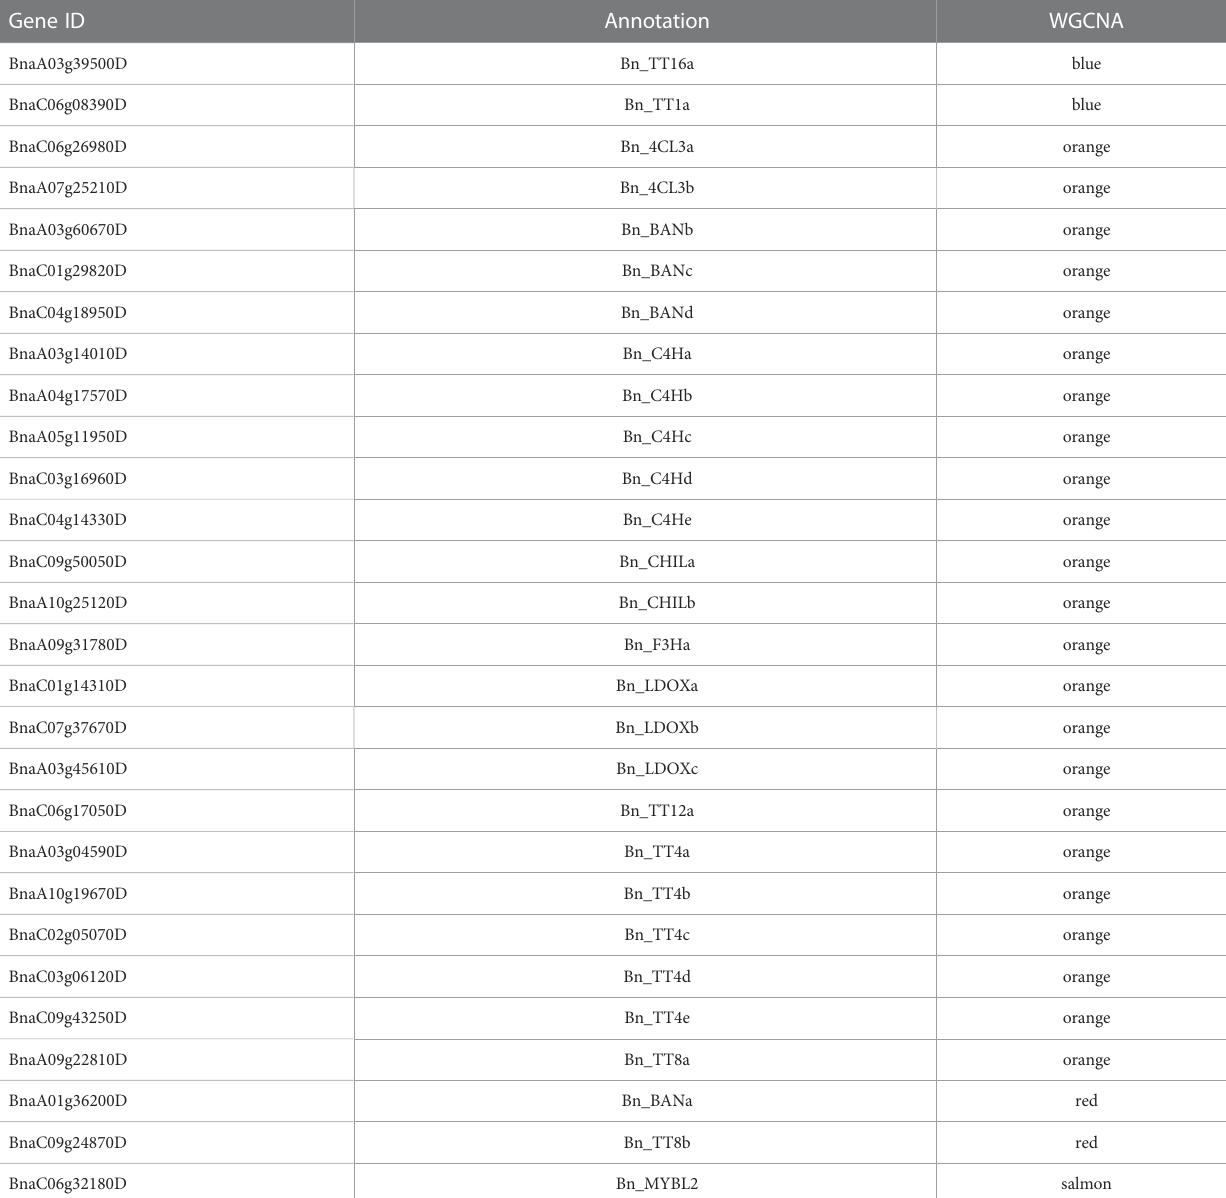
TABLE 2 WGCNA of DEGs associated with the fl avonoid biosynthesis pathway in